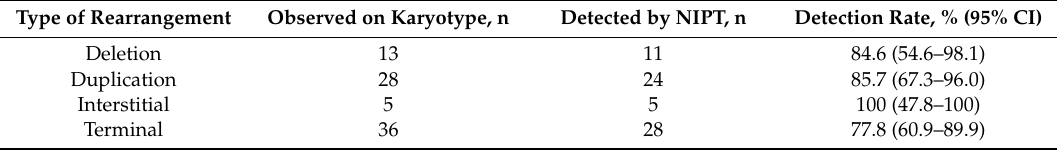
Table 3. Unbalanced structural rearrangements observed in study samples.